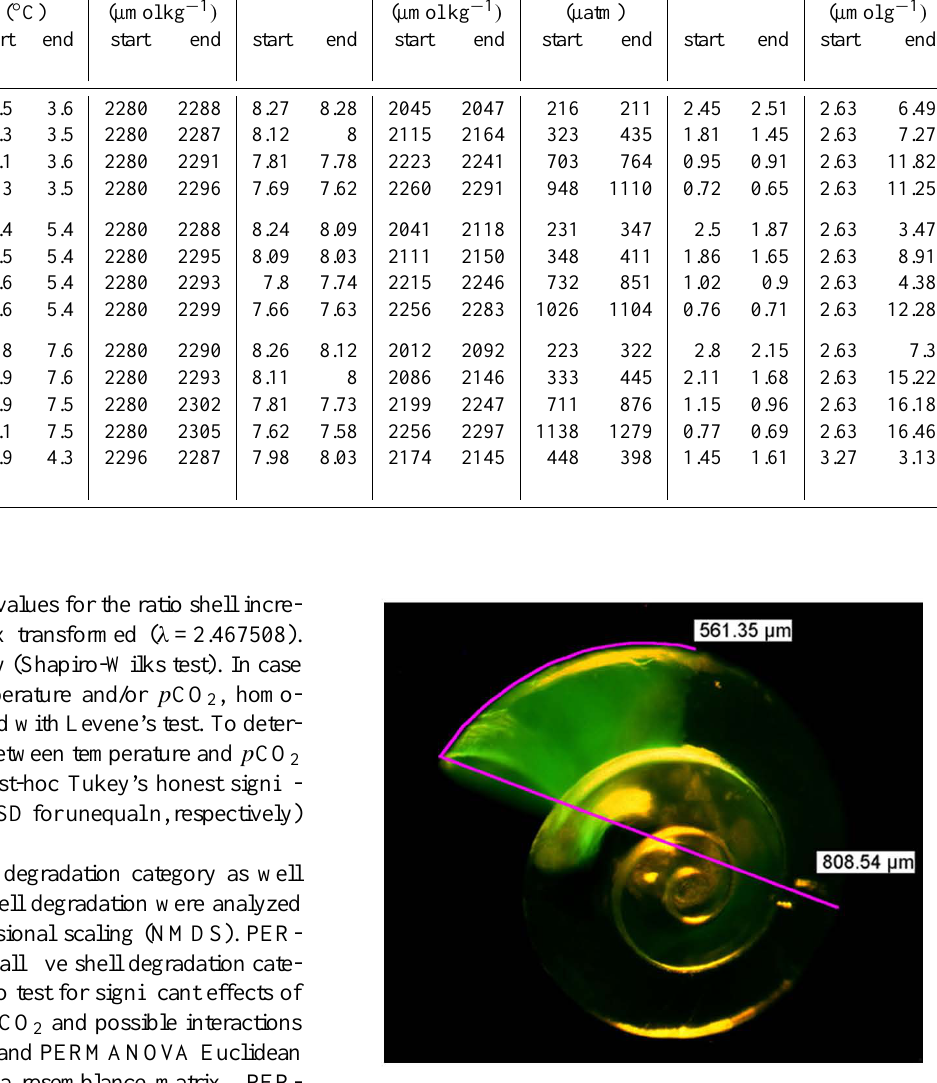
Fig. 5. Calcein stained shell of Limacina helicina showing shell increment during the experiment and measurement of increment length and